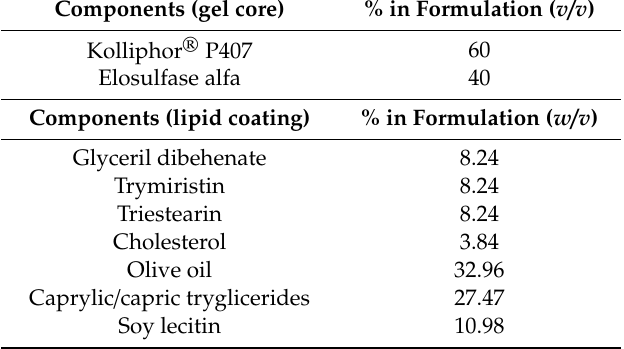
Table 1. Main composition of the nanostructured lipid carrier (NLC) used for elosulfase alfa encapsulation. Components (gel